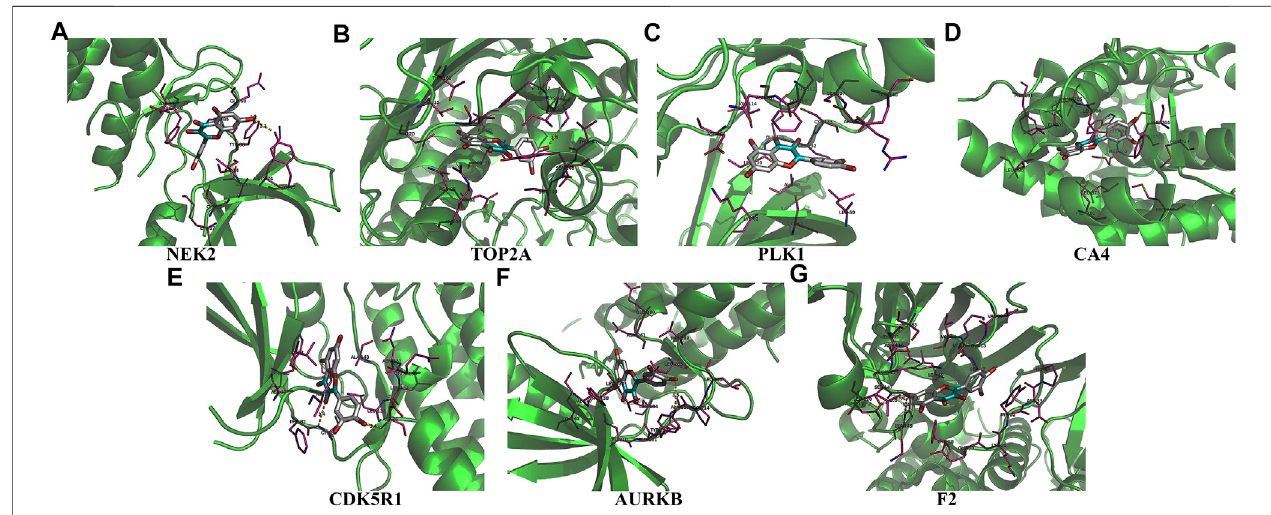
FIGURE 5 | The molecular docking between quercetin and risk model genes. (A) NEK2; (B) TOP2A; (C) PLK1; (D) CA4; (E) CDK5R1; (F) AURKB; (G) F2.